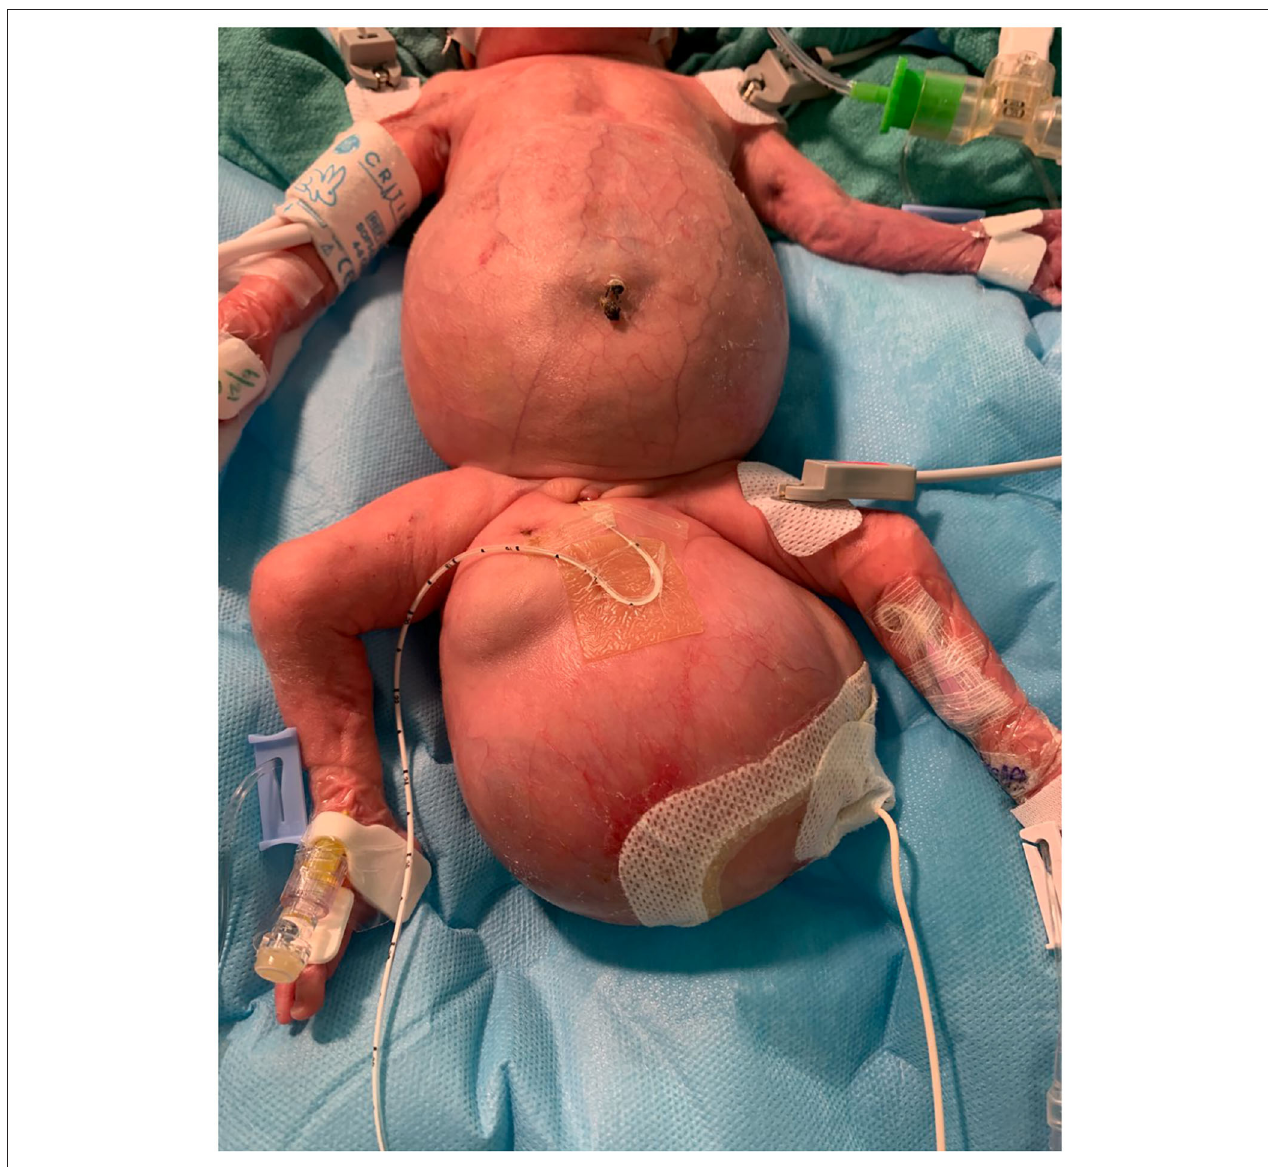
FIGURE 2 | Fetus-in-fetu prior to operative resection.